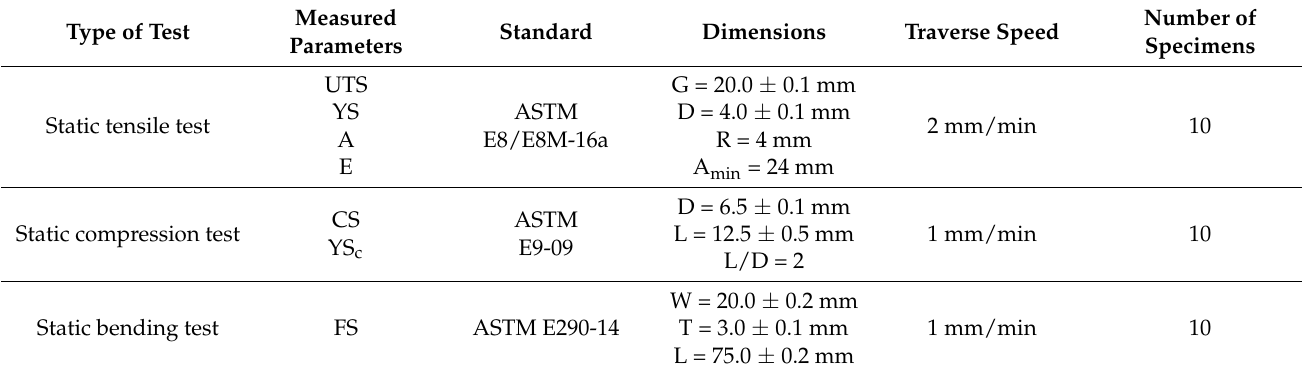
Table 1. Parameters of mechanical tests of Ti13Nb13Zr